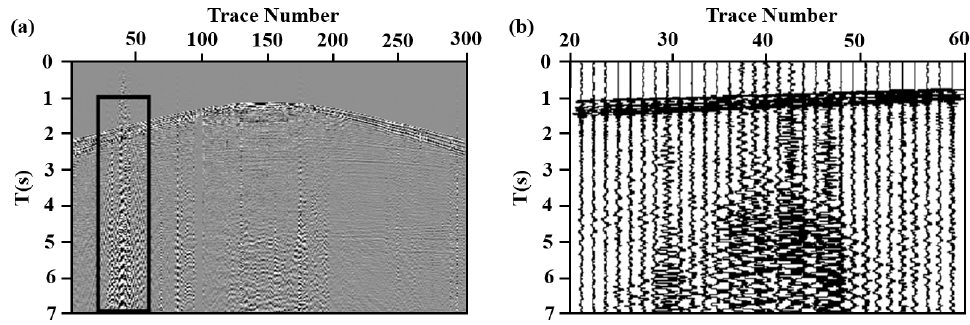
Figure 2. ( a ) The real data including road noises; ( b ) the main characteristics of the road noises zoomed from the black box.